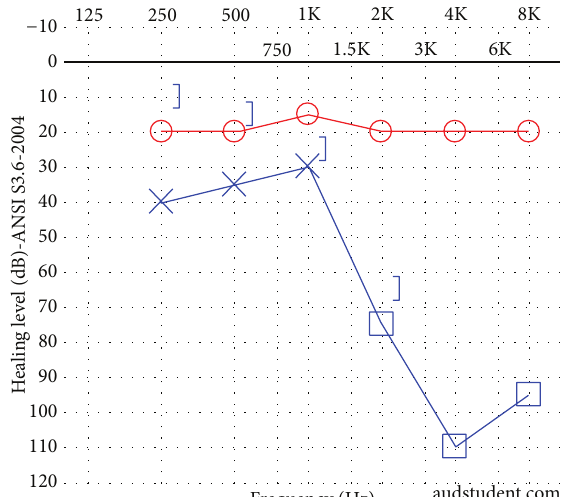
Figure 1: Audiogram of patient in Case 1. A left mixed hearing loss is present.